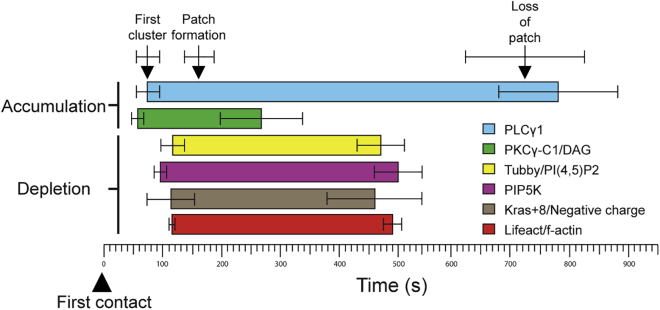
Time Course of PIP5K Association at the SynapseDiagram of the average times (see Table S1) of accumulation (PLCγ1 [blue] and DAG/PKCg-C1 domain [green]) or depletion (Tubby/PI(4,5)P2 [yellow], PIP5K [magenta], Kras+8/negative charge [brown], and Lifeact/F-actin [red]) with the probes subsequent loss or recovery during synapse formation (error bars represent SEM). See also Figure S5.